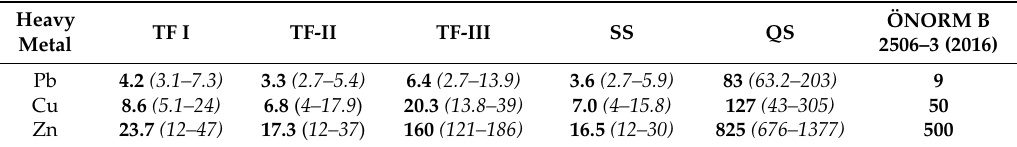
Table 3. Remobilization of previously adsorbed metals during road de-icing salt application (42 L solution of 5 g/L NaCl). Mean effluent metal concentrations are indicated in bold numbers and the Italic values in bracket are ranges.